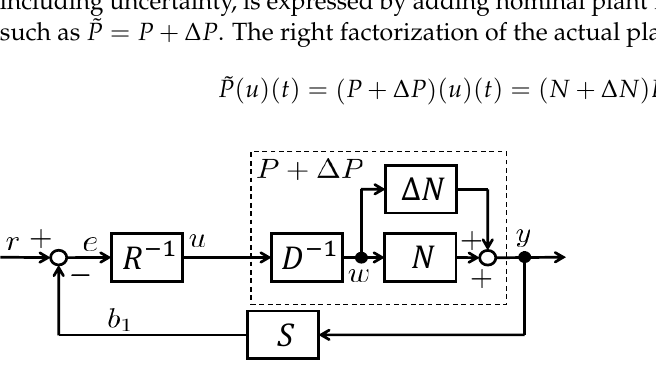
Figure 3. Nonlinear feedback system including